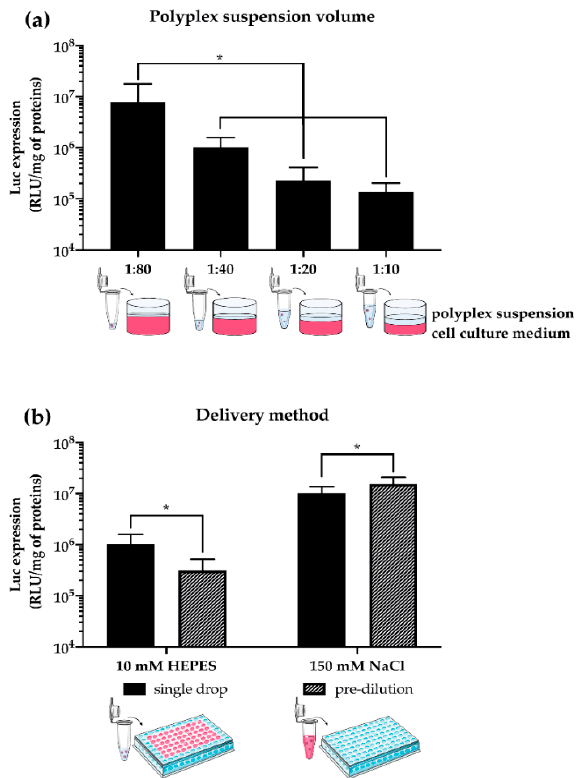
Figure 6. Effect of the volume of polyplex suspension and the delivery method on the transfection efficiency of pDNA/ l PEI complexes prepared at N/P 30 in L929 cells. ( a ) Transfection efficiency of pDNA/ l PEI complexes as a function of the polyplex volume:medium volume ratio. Complexes were